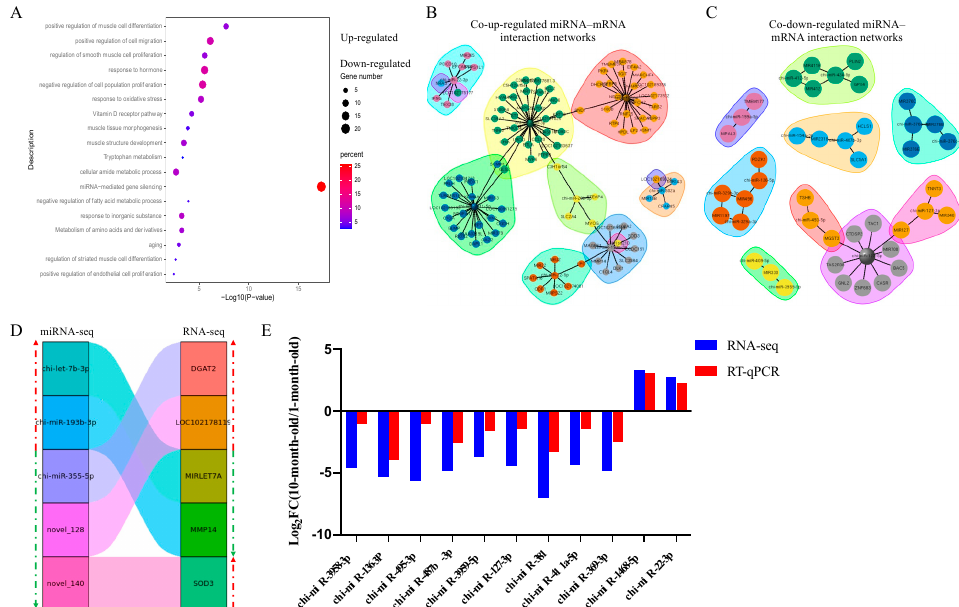
Figure 5. Function enrichment and joint analysis of DEMs and DEGs. ( A ) Function enrichment analysis of common DEM target genes in longissimus dorsi of goat. Light green represents terms of up-regulated miRNA target genes; Light red represents terms of down-regulated miRNA target genes. ( B ) The co-up-regulated miRNAs and target genes interaction networks in longissimus dorsi of goat. ( C ) The co-down-regulated miRNAs and target genes interaction networks in longissimus dorsi of goat. ( D ) miRNA–mRNA negative correlation network in longissimus dorsi of goat. The green arrow represents the down-regulated genes and miRNAs, and the red arrow represents up-regulated genes and miRNAs. ( E ) RT-qPCR of DEMs compared with RNA-seq. Results of RT-qPCR analysis (Parallel analysis with RNA-seq results) of DEMs fold-change in longissimus dorsi between Longlin. The relative expression of each miRNA was calculated using the 2 − ∆∆ ct method. The data are presented as mean ± SEM from three independent